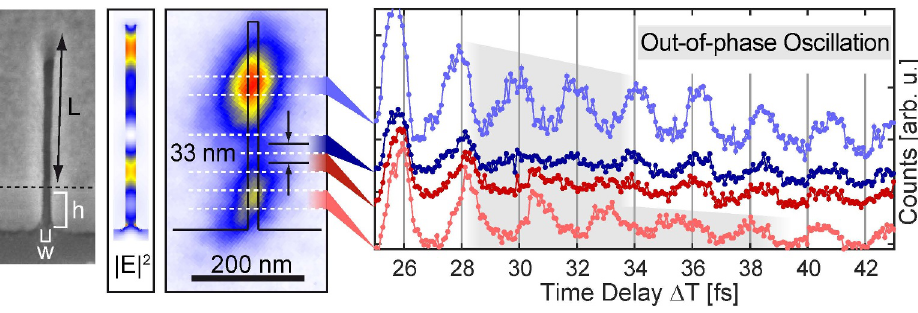
Fig. 2. From left: Scanning electron micrograph of a sample slit with L = 360 nm, h = 31 nm, w = 19 nm; simulated field intensity distribution from finite difference time domain simulations with the same geometrical parameters; photoemission electron microscopy image. Horizontal dashed lines indicate cross-line ranges for delay-dependent PEEM data